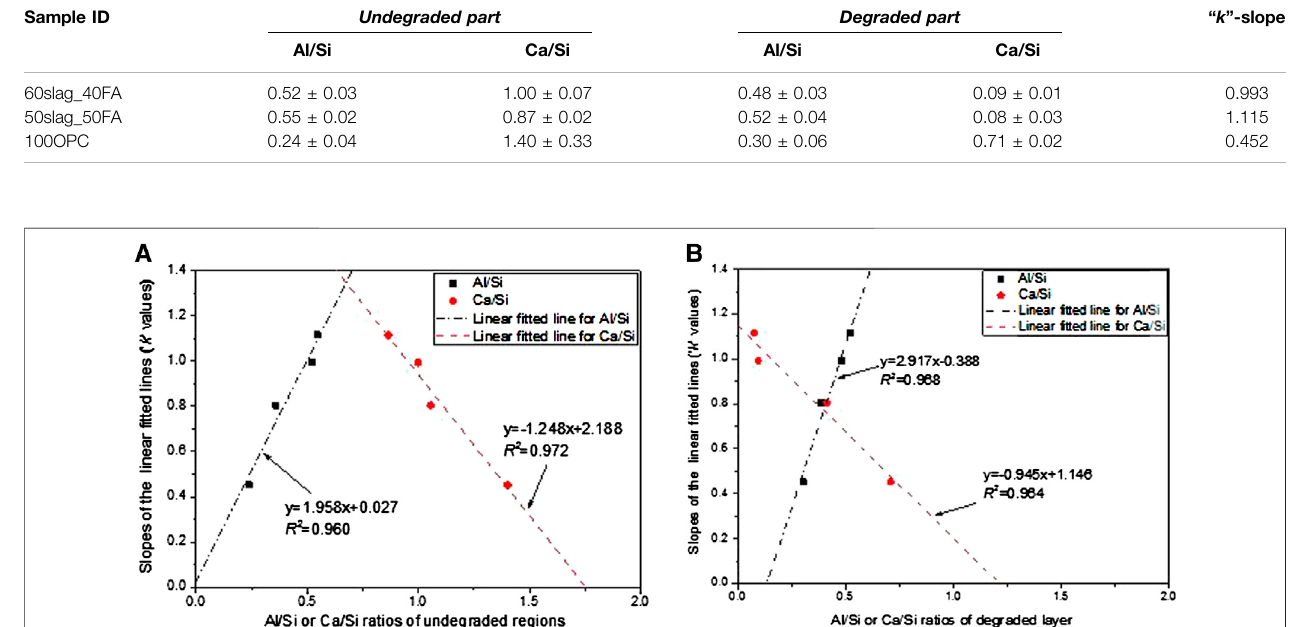
FIGURE 9 | Al/Si and Ca/Si ratios in the (A) undegraded layer and (B) degraded layer of the four different mortar mixes.